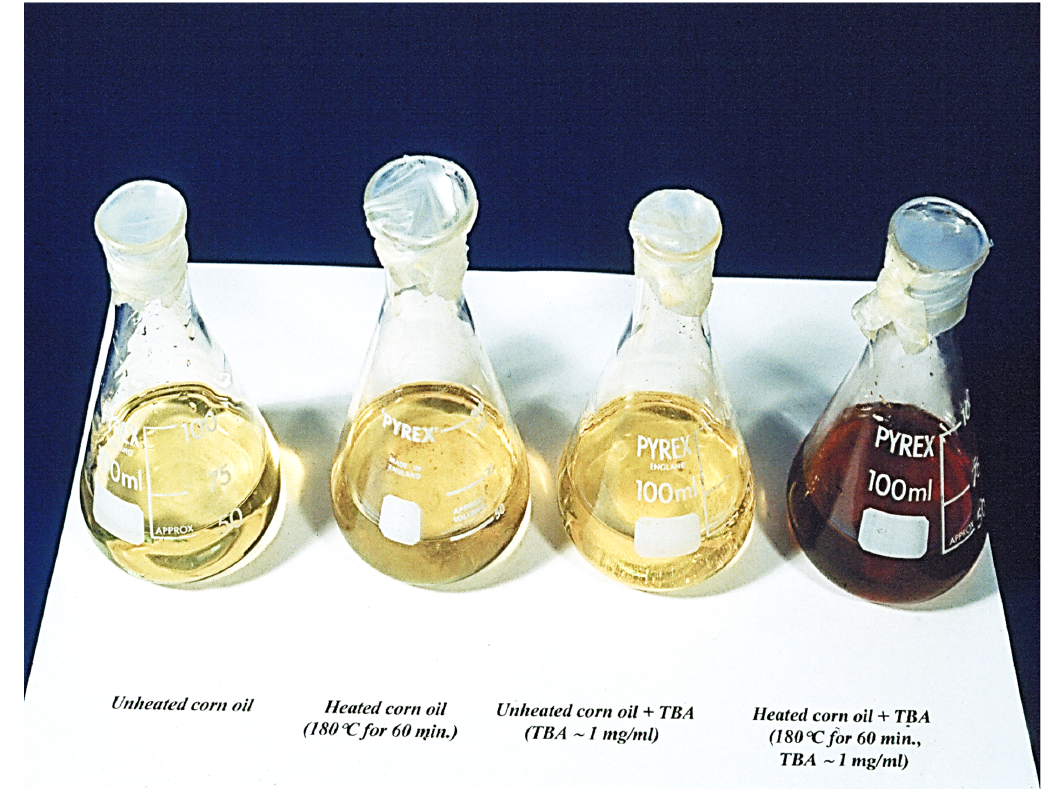
Figure 7. Aldehyde-sensitive visual chromogenic thiobarbituric acid (TBA) test applied to unheated and thermally- stressed corn oil samples. Far left, unheated corn oil; centre left, corn oil heated at 180 ◦ C for a period of 60 min; centre right, unheated corn oil containing 1 mg/mL TBA reagent; far right, corn oil heated at 180 ◦ C for a 60 min duration, but following addition of TBA (final added level 1.0 mg/mL). Photograph taken at Prof. Grootveld’s laboratory based at St. Bartholomew’s and the Royal London Hospital School of Medicine and Dentistry, circa 1995. Reproduced from Ref. [11] with